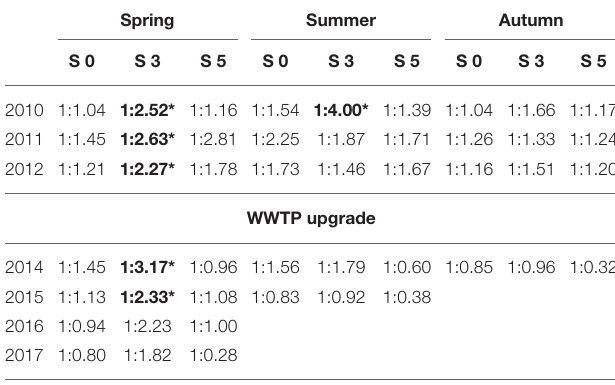
TABLE 1 | Ratio of male to female gammarids in spring, summer, and autumn prior to (2010–2012) and after (2014–2017) the wastewater treatment plant (WWTP)